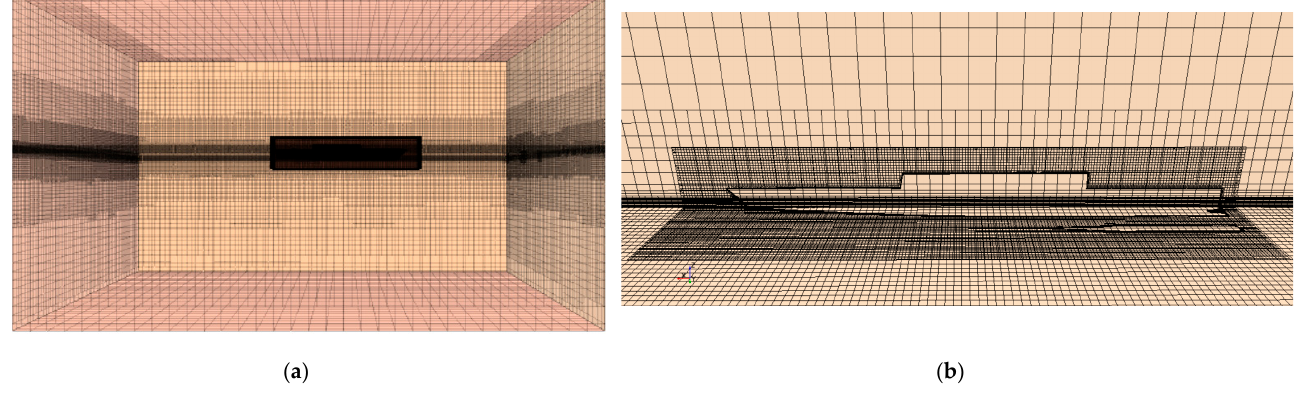
Figure 6. General view of the computational mesh. ( a ) Refined meshes of flow field; ( b ) Overview of the refined meshes around the hull.